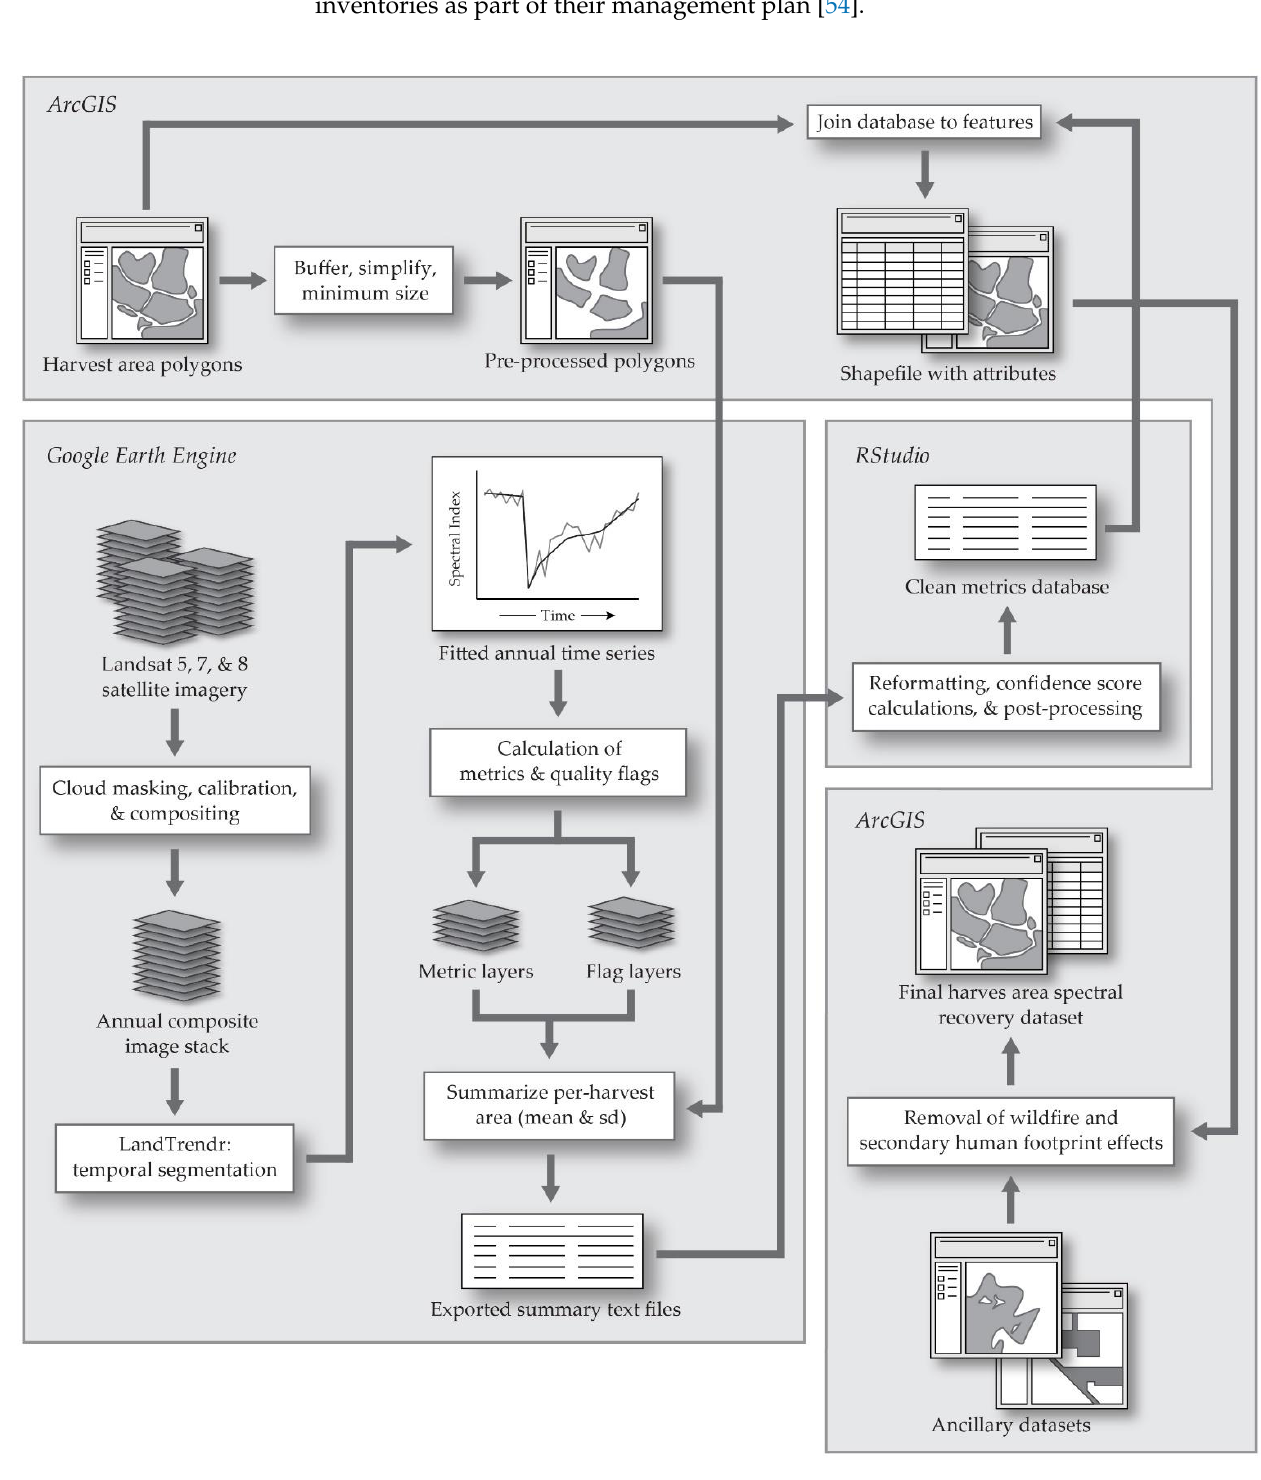
Figure 2. Flowchart showing the described workflow for deriving post-disturbance spectral recovery using Landsat time series.